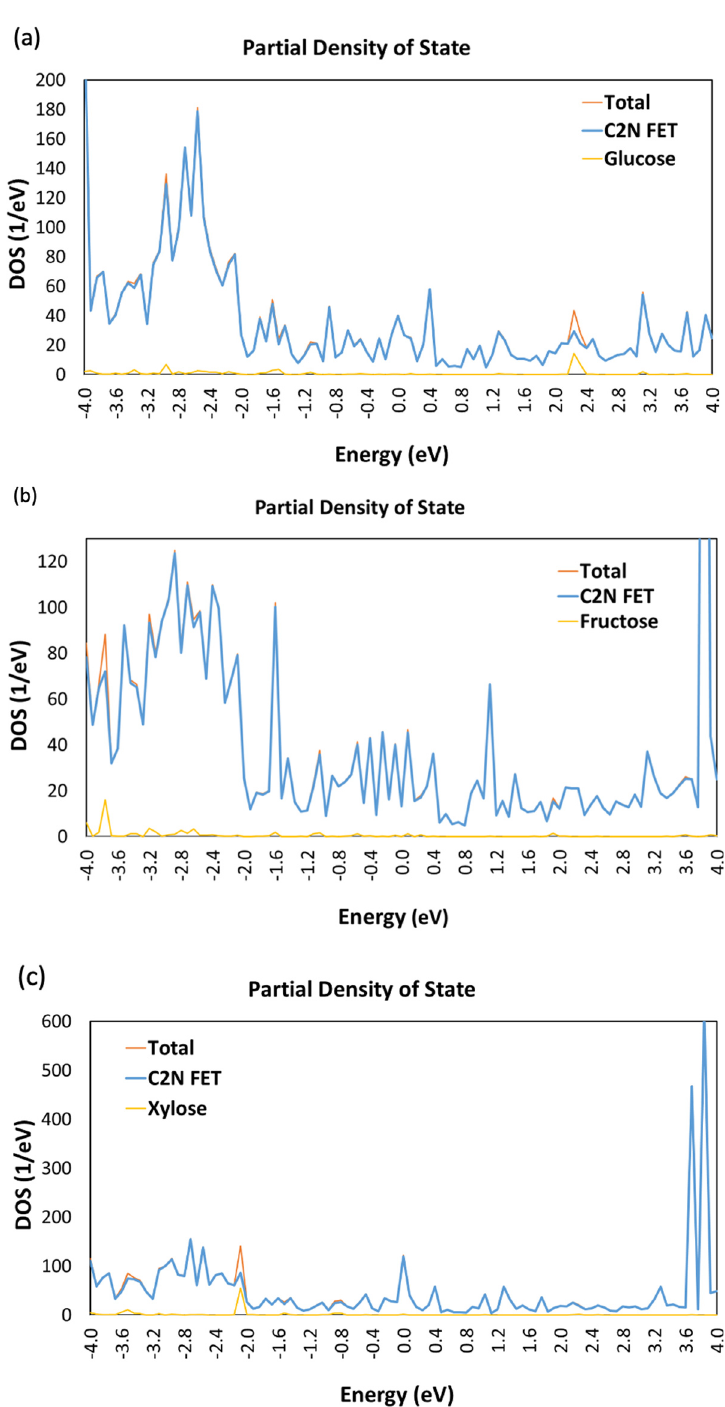
Figure 5. Total and partial density of states (DOS) of C 2 N FET in presence of ( a ) glucose molecule, ( b ) fructose molecule, and ( c ) xylose molecule.